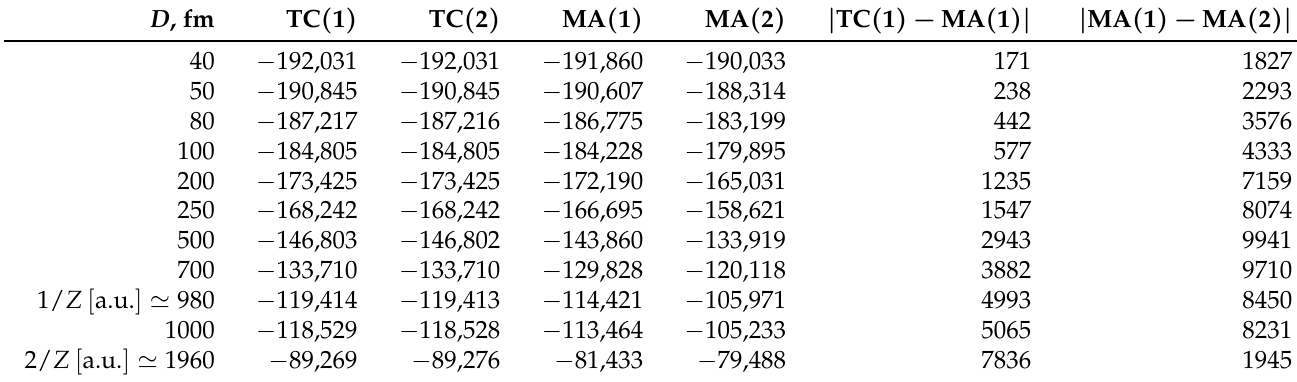
Table 3. Ground-state binding energy E 1 σ Table